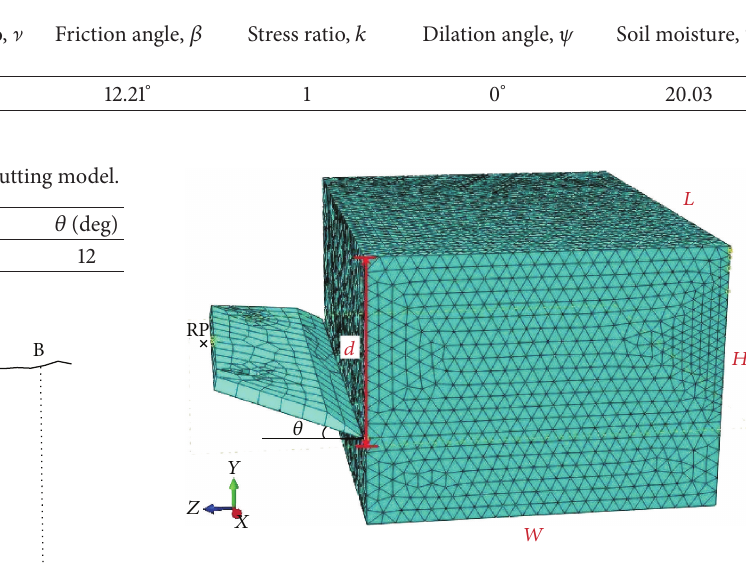
Figure 4: Soil-cutting model